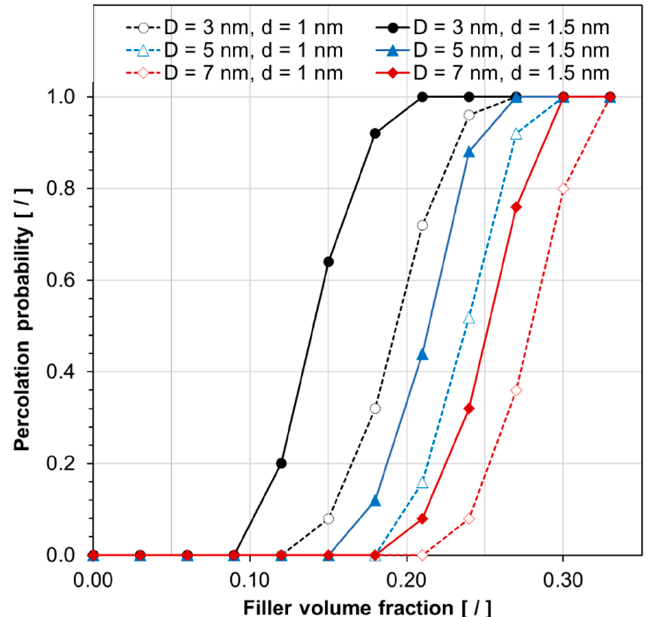
Figure 14. The probability of reaching electrical percolation, for an effective electrical conductivity threshold of 1.0 S/m, versus filler volume fraction for silver/epoxy nanocomposites with different particle sizes ( D ) and tunneling distances ( d ).